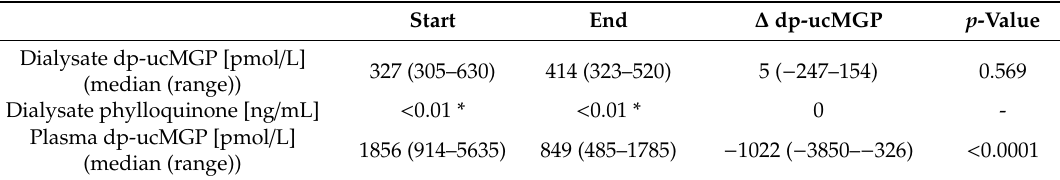
Table 3. Vitamin K-related variables in dialysate and plasma.